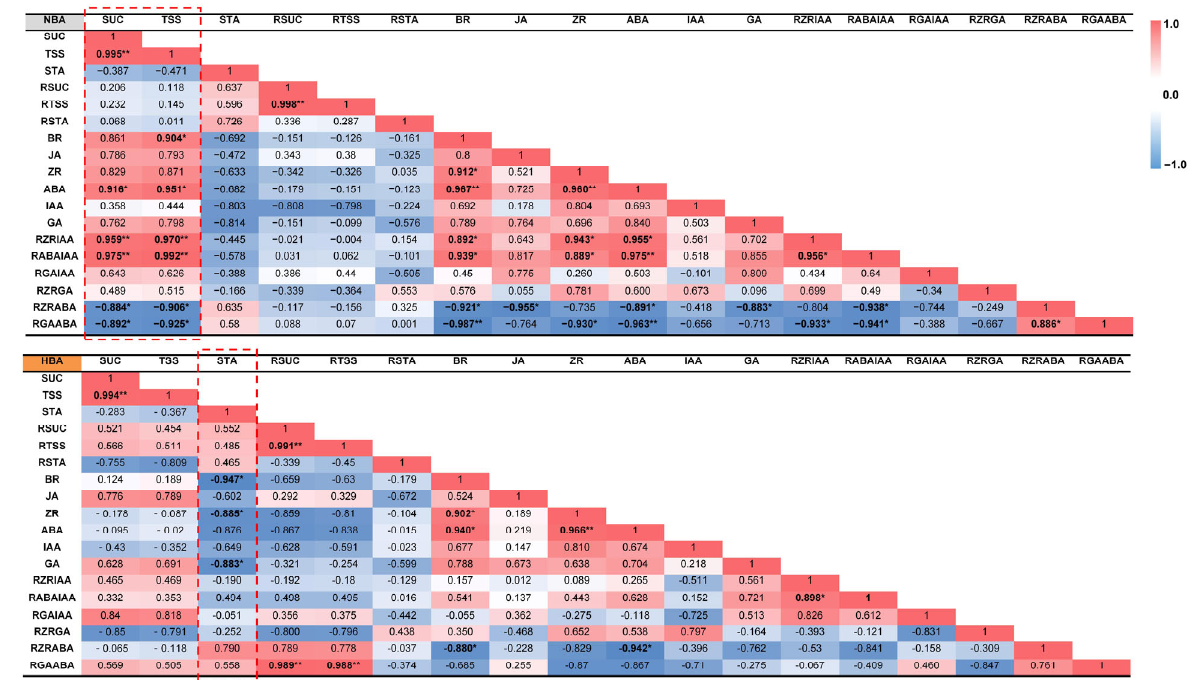
Figure 5. Heatmaps of correlations between endogenous hormone and non-structural carbohydrate indices during in vitro bulblet regeneration of the NBA and HBA groups. * represents significant at p < 0.05, ** represents significant at p < 0.01. SUC: sucrose, TSS: total soluble sugar, STA: starch, RSUC, RTSS and RSTA indicate the changing ratio of SUC, TSS and STA contents at adjacent time points, respectively. RZRIAA, RABAIAA, RGAIAA, RZRGA, RZRABA, RGAABA indicate the changing ratios between the two hormone contents during the in vitro bulblet regeneration process of Ls . For example, RZRIAA represents the ratio of ZR content to IAA content during in vitro bulblet regeneration. Correlation analyses of LBA group is shown in Figure S2, with no significant correlations between endogenous hormone and non-structural carbohydrate